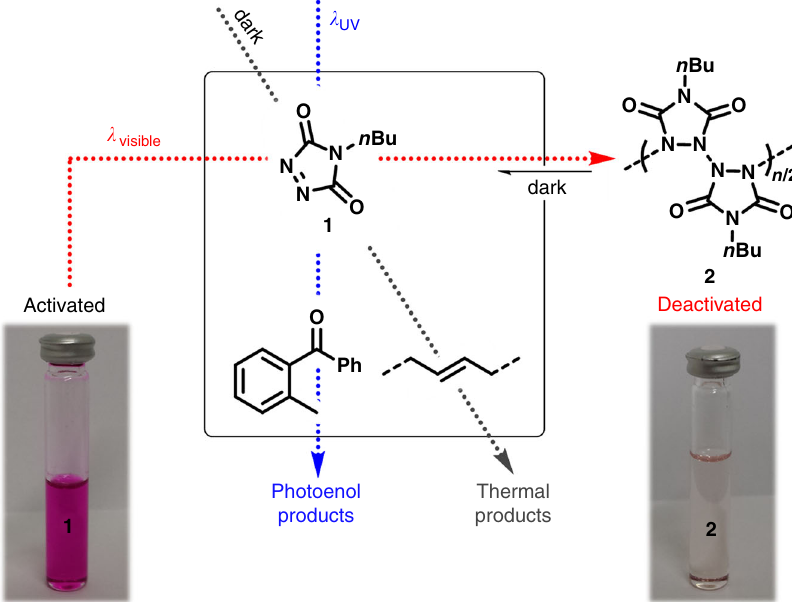
Fig. 1 Schematic representation of the introduced light-controlled manifold. The photodeactivation of triazolinediones (TADs) under visible light irradiation enables a UV light-switchable reaction selectivity between a photoenol and thermal TAD-based